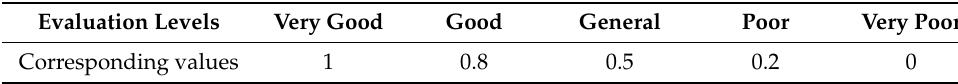
Table 9. Corresponding values of evaluation levels. Evaluation Levels Very Good Good General Poor Very Poor Corresponding values 1 0.8 0.5 0.2